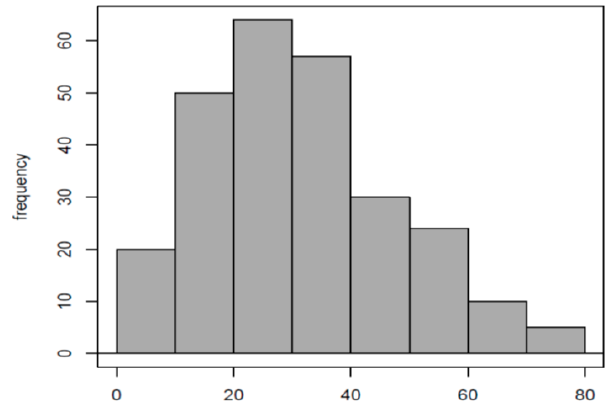
Figure 4. Normal distribution of the PAOT-Skin Score ® observed among 263 healthy volunteers (Group I). Reference values were calculated as ranging from 0–62.94.